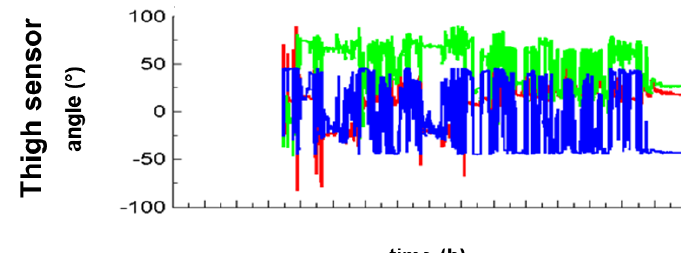
Figure 7. Artifacts of thigh sensors . Visualized accelerations in sagittal axis ( blue ) show artefacts most probably due to spontaneous leg movements, restless legs or spasticity in the cohort of immobile patients suffering from severe neurological diseases such as stroke or traumatic brain injury.